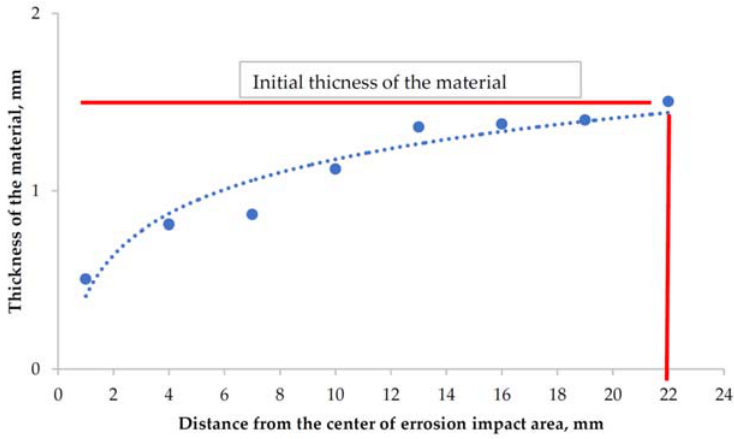
Figure 9. Crater diameter in the investigated samples.